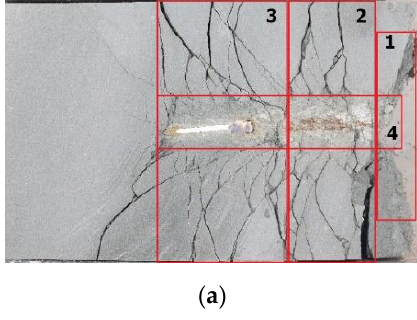
Figure 9. Internal crack of the limestone target at a projectile impact speed of 913 m/s: ( a ) experimental result; ( b ) numerical simulation results.